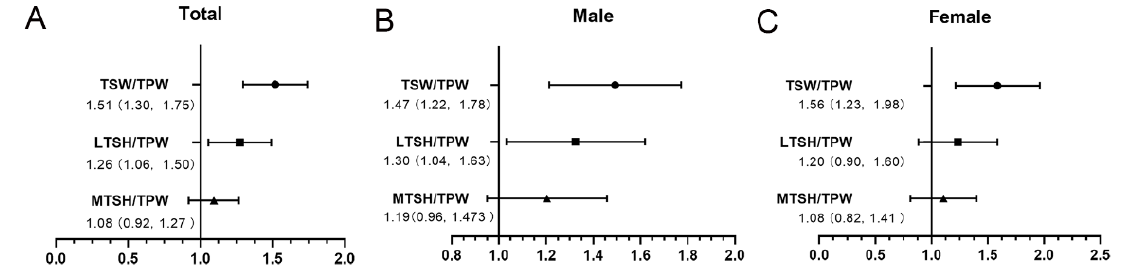
Figure 3. Receiver operating characteristic curves of three normalized tibial spine width or height in all the patients together ( A ), in males ( B ), and in females ( C ). The area under the curve ( p value) is shown, with a value greater than 0.7 indicating fair to good diagnostic capacity. TSW, tibial spine width; LTSH, lateral tibial spine height; MTSH, medial tibial spine height; TPW, tibial plateau width.